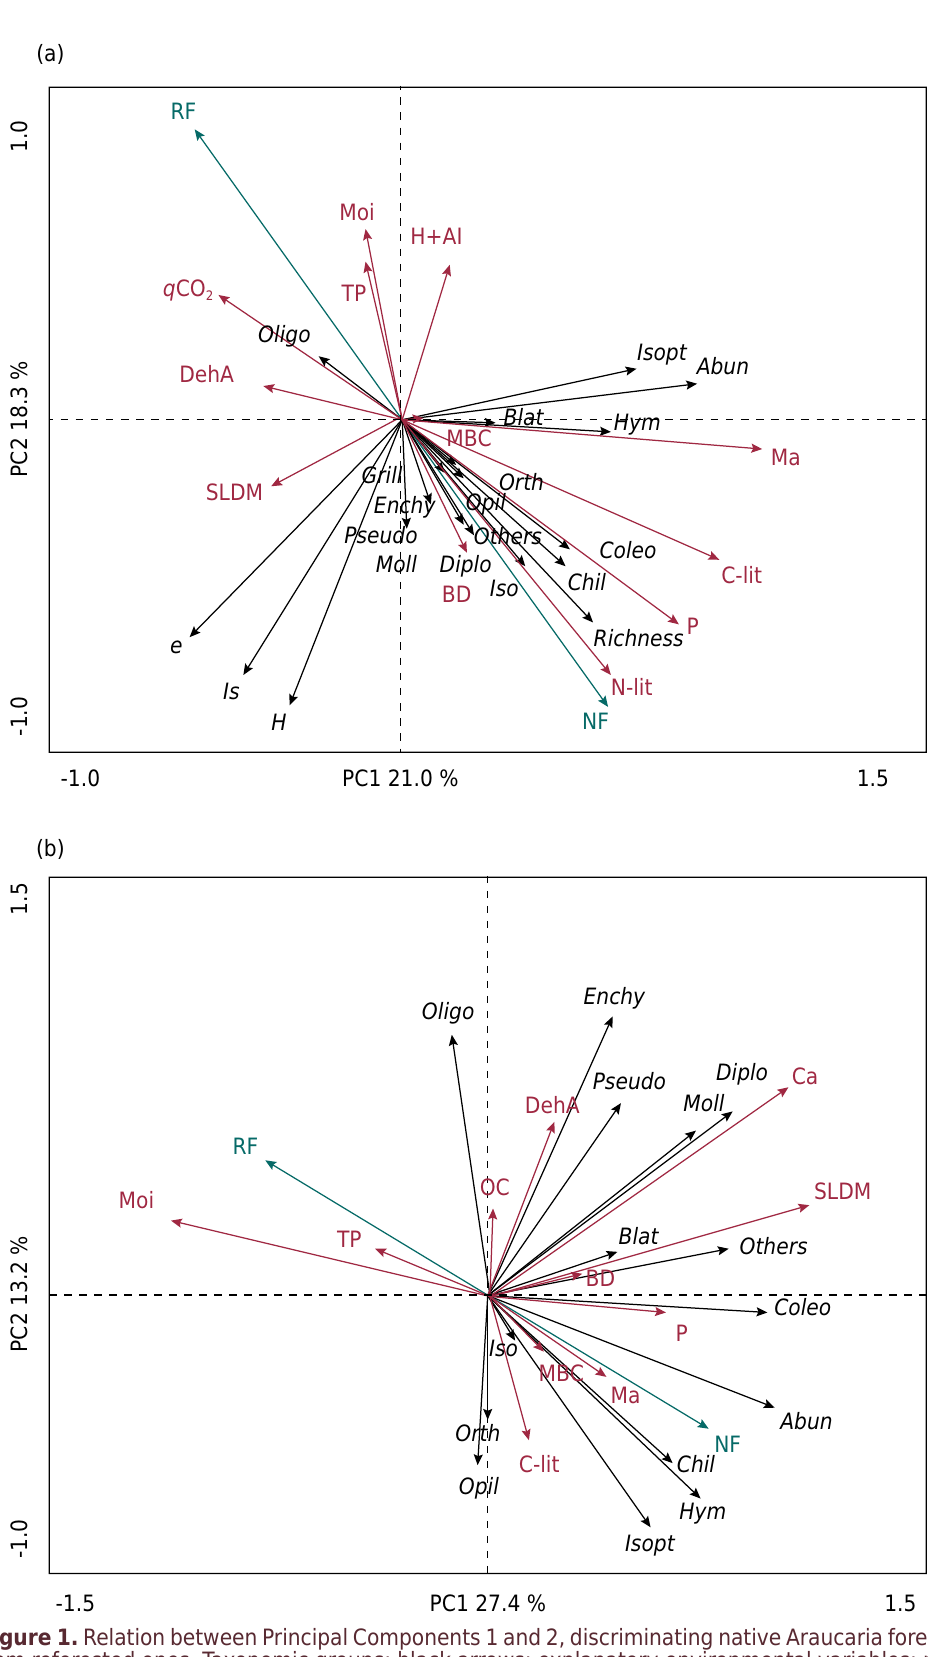
Figure 1. Relation between Principal Components 1 and 2, discriminating native Araucaria forests from reforested ones. Taxonomic groups: black arrows; explanatory environmental variables: red arrows, in winter (a) and summer (b). Diplo: Diplopoda; Iso: Isopoda; Coleo: Coleoptera; Hym: Hymenoptera; Isopt: Isoptera; Blat: Blattodea; Orth: Orthoptera; Pseudo: Pseudoscorpionidae; Chil: Chilopoda; Opil: Opilionidae; Moll: Mollusca; Enchy: Enchytraeidae; Grill: Grilloblatodea; Others: other less abundant groups. Dens: density; H: Shannon’s diversity index; Is: Simpson’s dominance index; e : Pielou’s evenness index; OC: organic carbon; C-lit: litter carbon; N-lit: litter nitrogen; Moi: moisture; TP: total porosity; Ma: Macroporosity; BD: bulk density; SLDM: surface litter dry matter; MBC: microbial biomass carbon; DehA: dehydrogenase activity; q CO 2 : metabolic